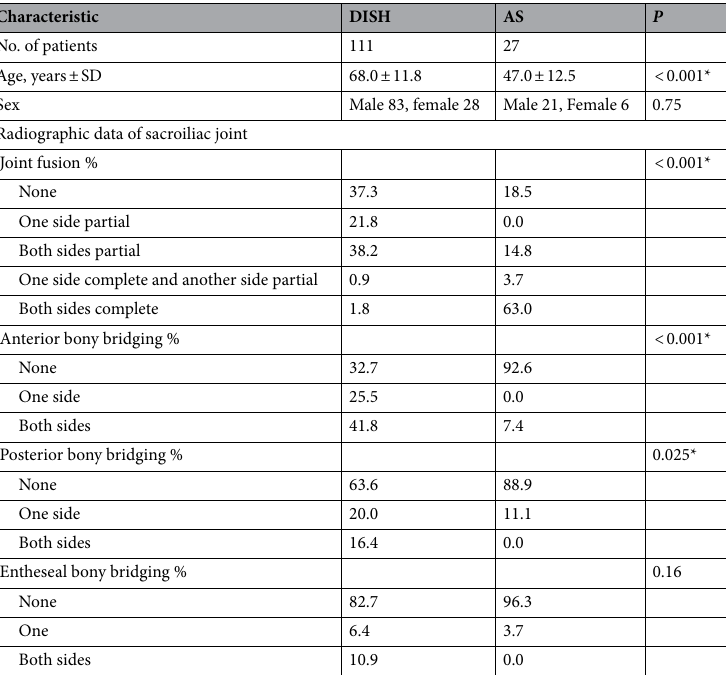
Table 1. Demographic data of patients. DISH Diffuse idiopathic skeletal hyperostosis, AS Ankylosing spondylitis, SD standard deviation. * P < 0.05.